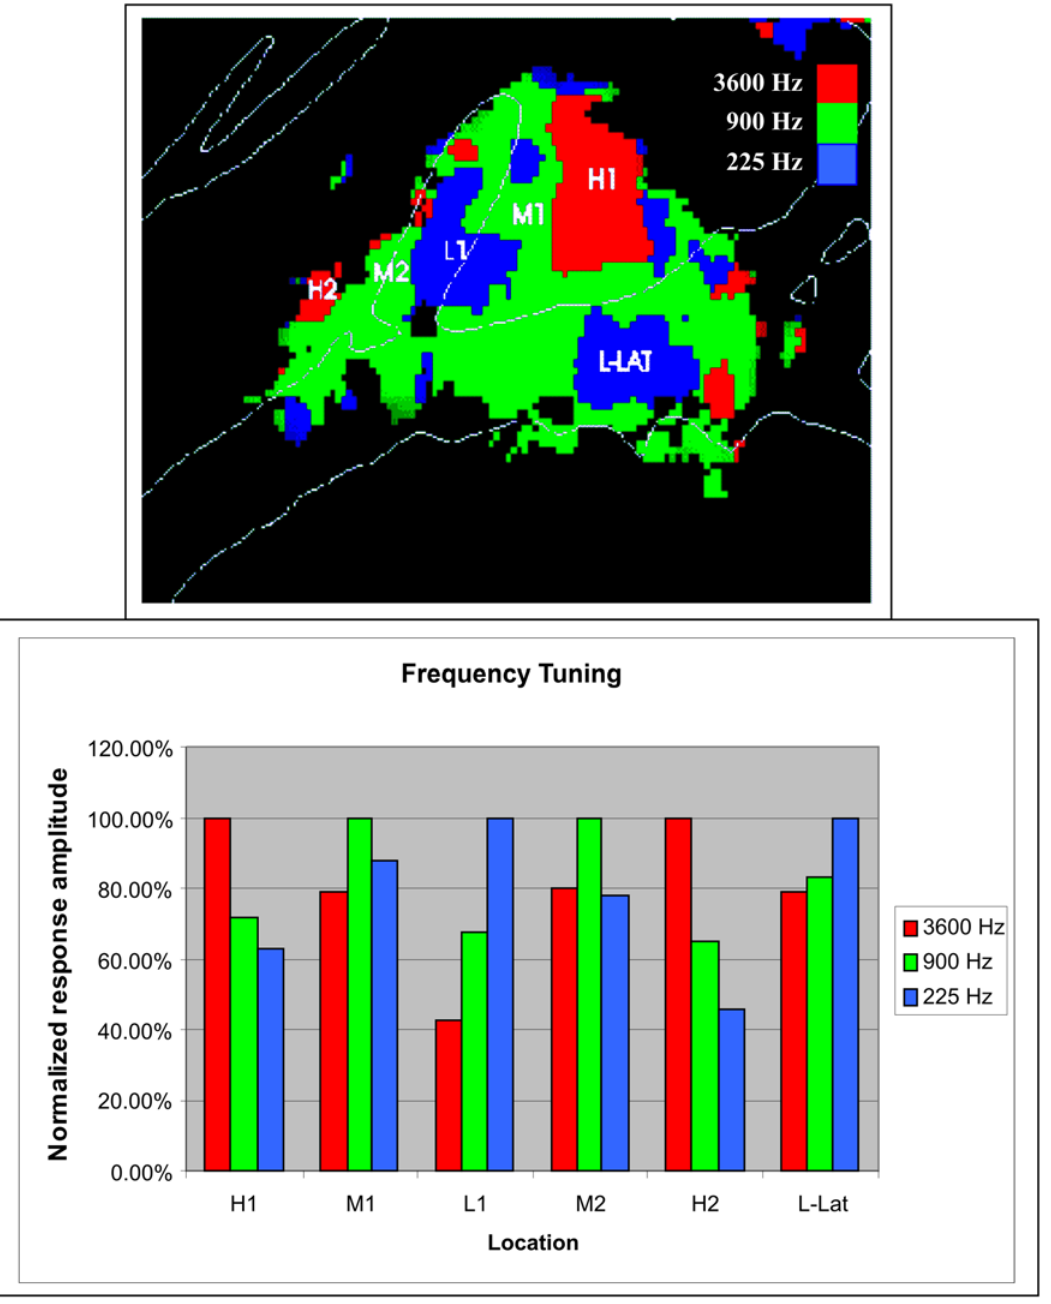
Figure 7. Frequency preferences at six different locations in auditory cortex. Locations of areas sampled in frequency specific regions are shown on a mean tonotopic map (top, averaged over all conditions). High- and low-frequency tuned tonotopic areas (H1, H2, and L1) showed relatively sharp tuning while regions tuned to mid-frequencies tended to also be activated to some extent by low and high frequency tones. Apparent tonotopic regions in lateral auditory cortex (L-Lat) were not sharply tuned. Normalized response amplitude shows the magnitude of response to each frequency as percentage of the response to the preferred frequency.